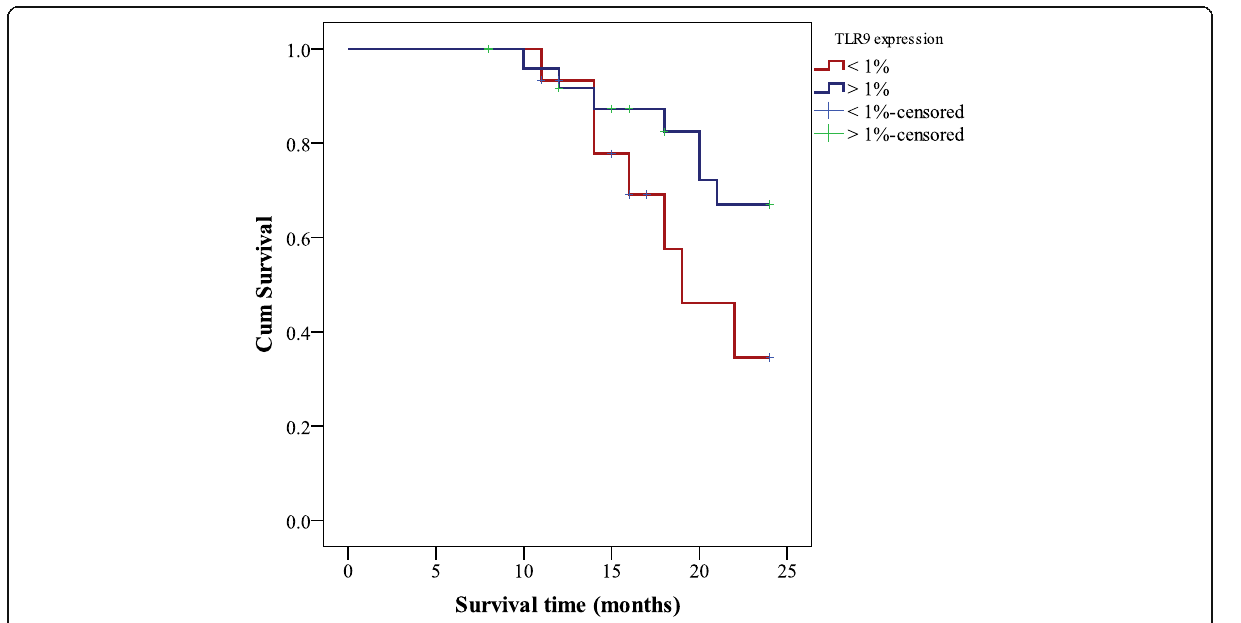
Fig. 4 The median overall survival time in regard to the cutoff value of